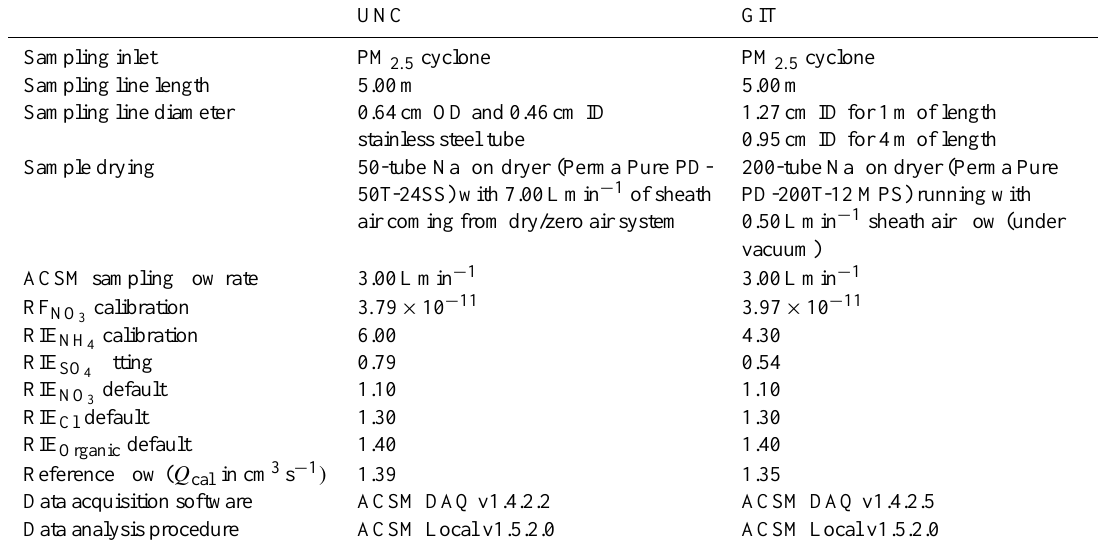
Table 1. UNC and GIT ACSMs sampling setup at the JST site for a short period between January–February